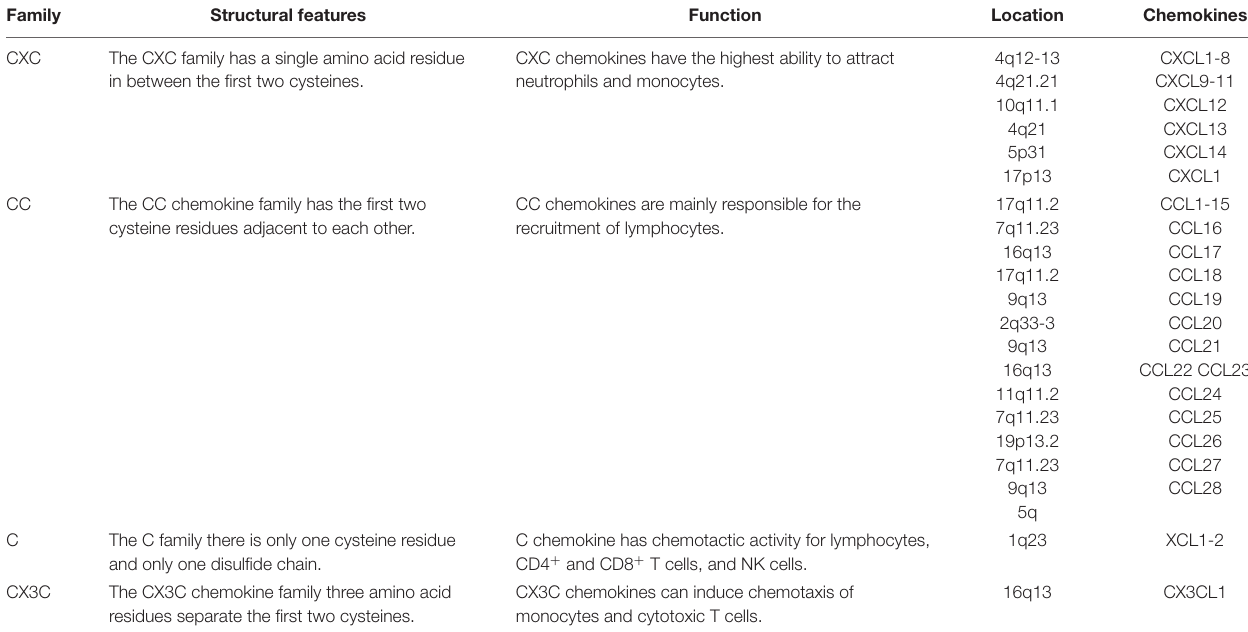
TABLE 1 | Classification, structural features, function, and location of the chemokine family members. Family Structural features Function Location